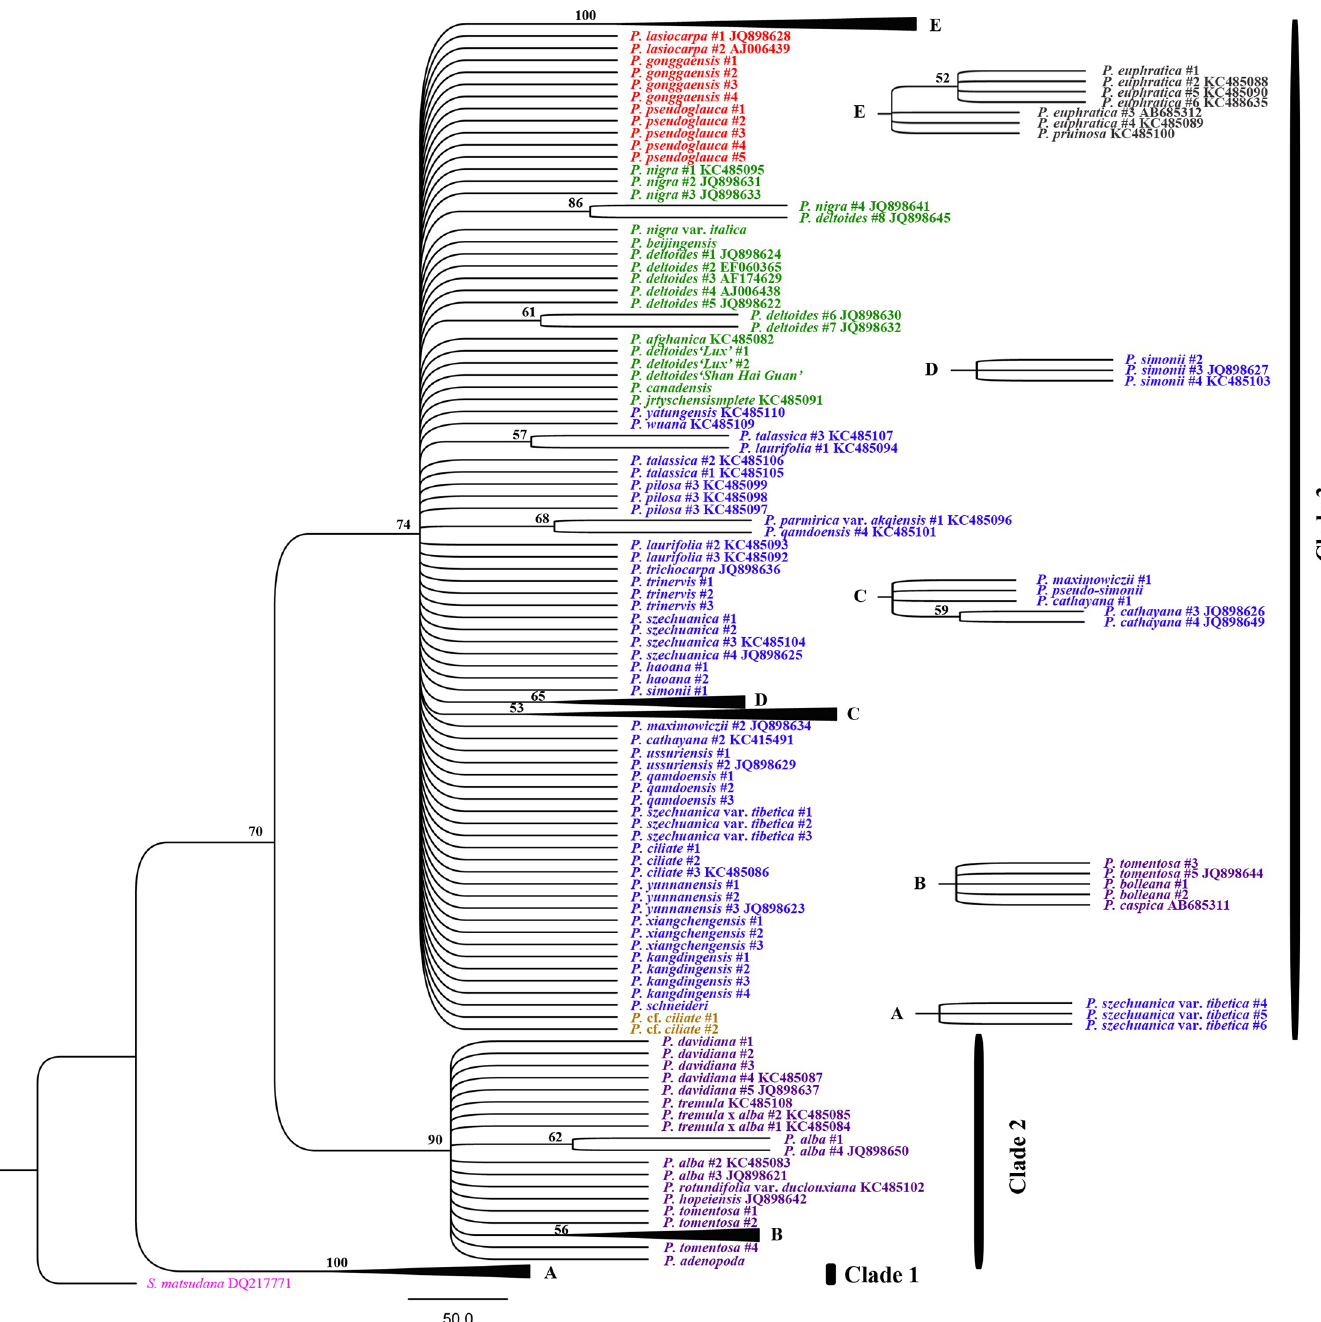
Fig 5. MP phylogenetic tree based on ITS regions. Bootstrap support values are reported for nodes over 50%. The traditional species taxa, based on morphological characteristics, are shown in different colors. The outgroup is pink, Tacamahaca is blue, Aigeiros is green, Leuce is purple, Leucoides is red, Turanga is brown, and hybrids are